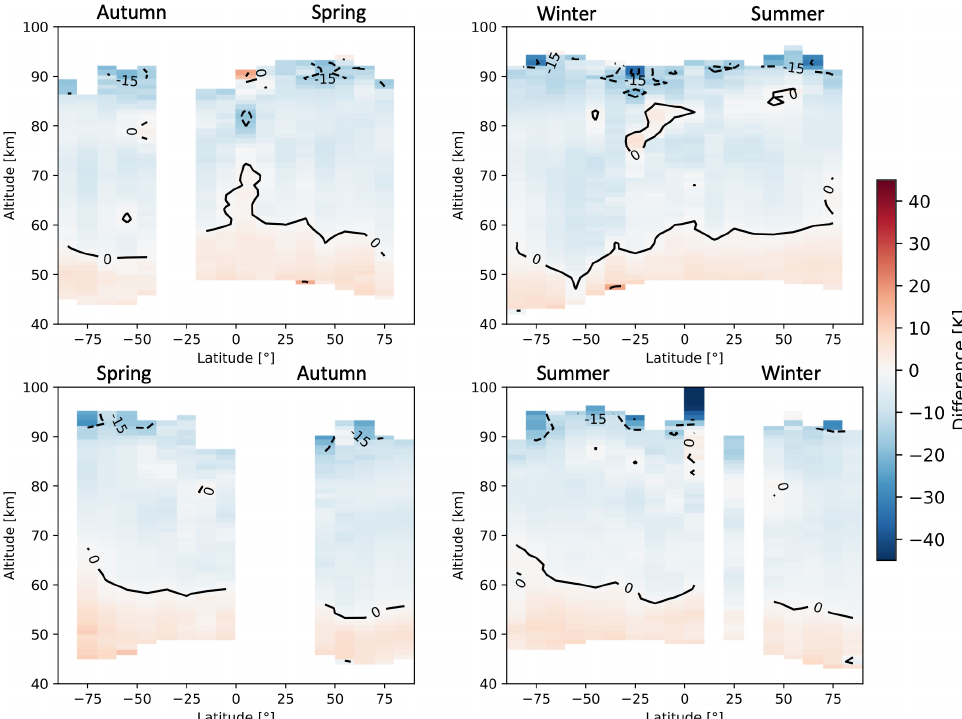
Figure A28. Seasonal zonal means of temperature FM19 SMR–ACE absolute differences averaged over the time period between February 2004 and April 2019. The seasons are intended as astronomical seasons, i.e. each starting at the respective solstice or